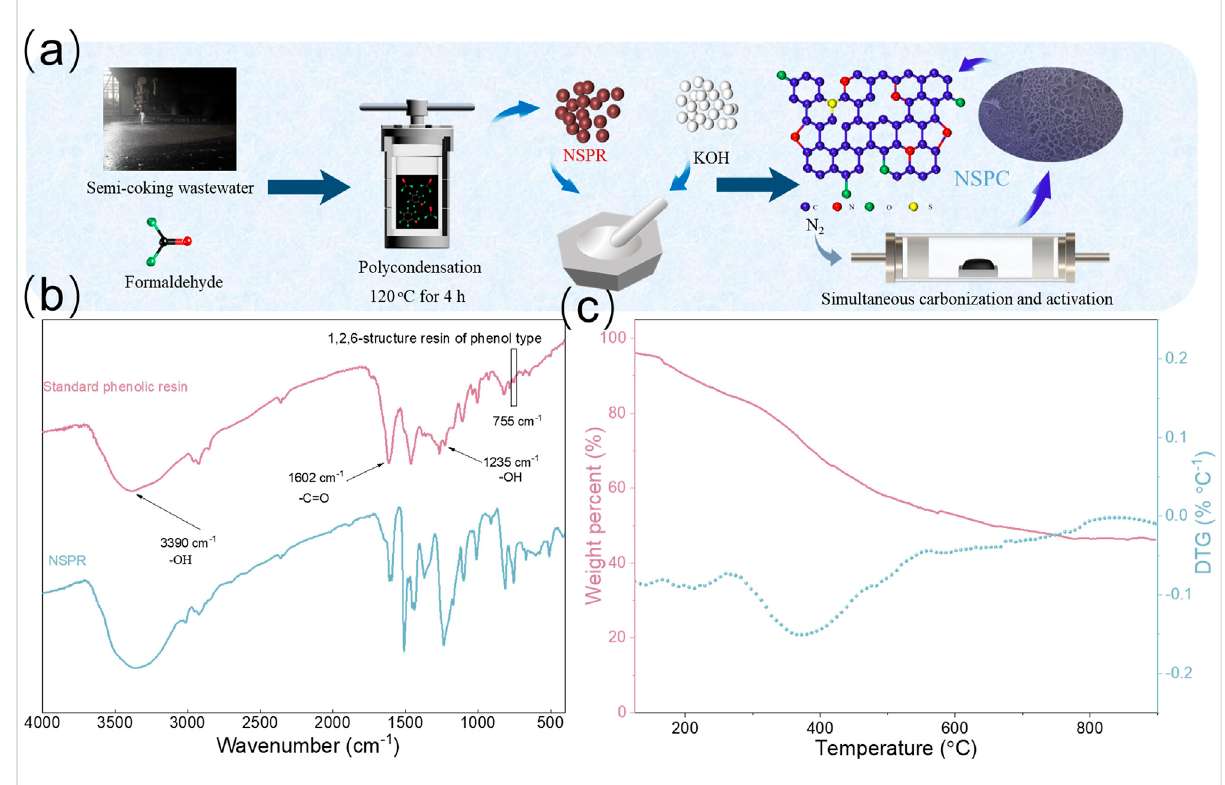
FIGURE 1 (A) Schematic diagram of the preparation process for NSPC, (B) FT-IR spectrum of NSPR, (C) TG/DTG